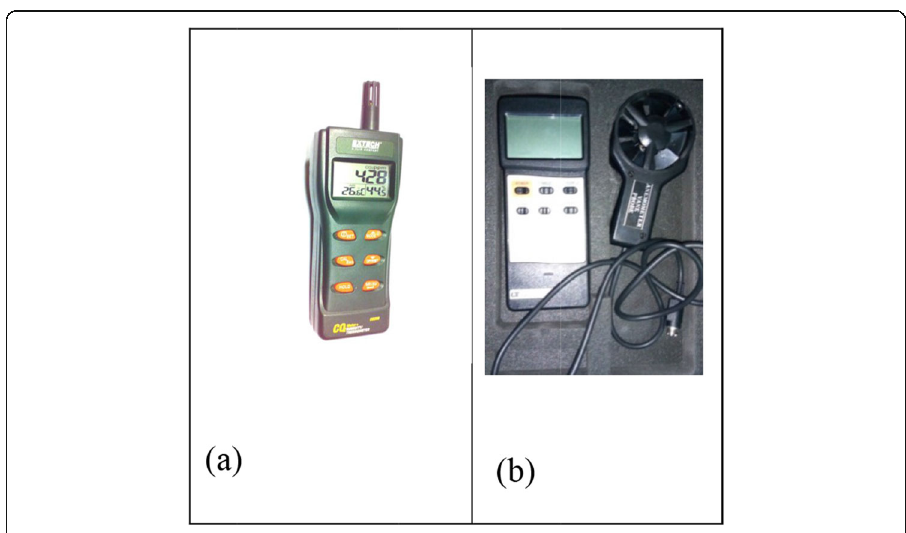
Fig. 2 Measurement devices used EXTECH portable CO 2 meter ( a ) and anemometer ( b ) (Source: from Environmental lab Cairo